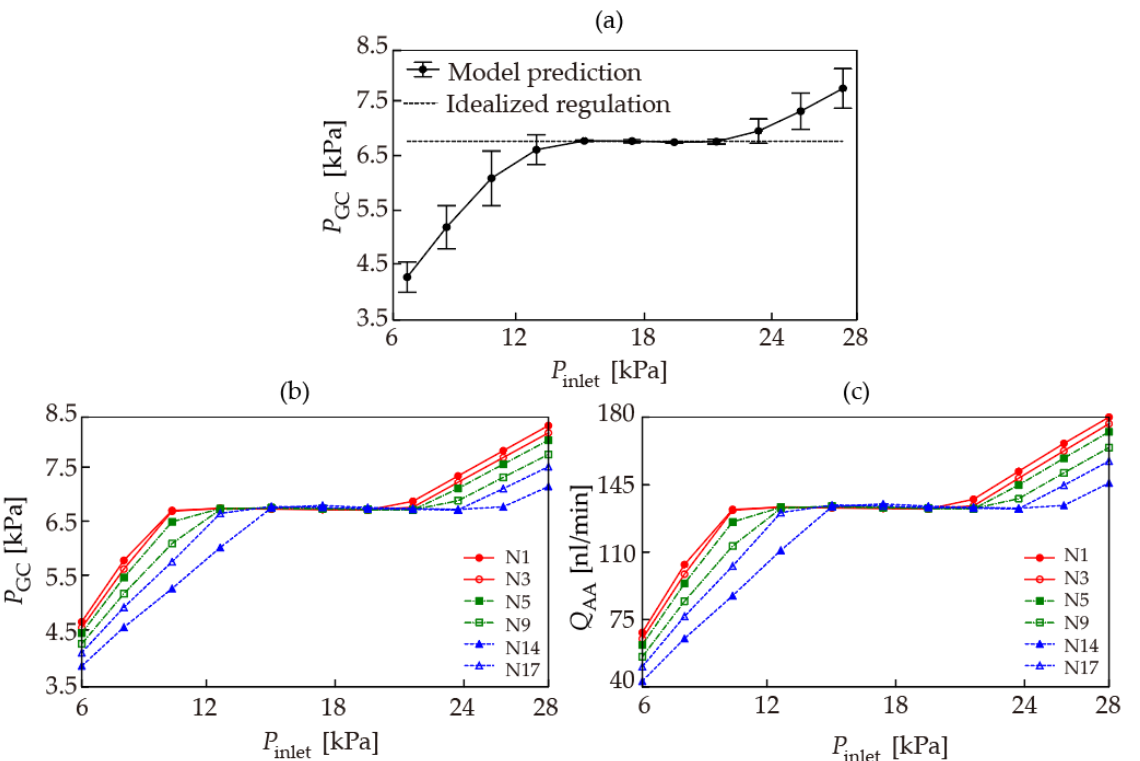
Figure 3. ( a ) Mean glomerular pressure P GC as a function of inlet pressure P inlet where the value of ‘Idealized regulation (cid:48) is 6.7 kPa [33–35]. ( b ) Glomerular pressure P GC and ( c ) AA flow rate Q AA of G1(N1, N3) G2(N5, N9), and G3 (N14, N17) as a function of P inlet of the vascular